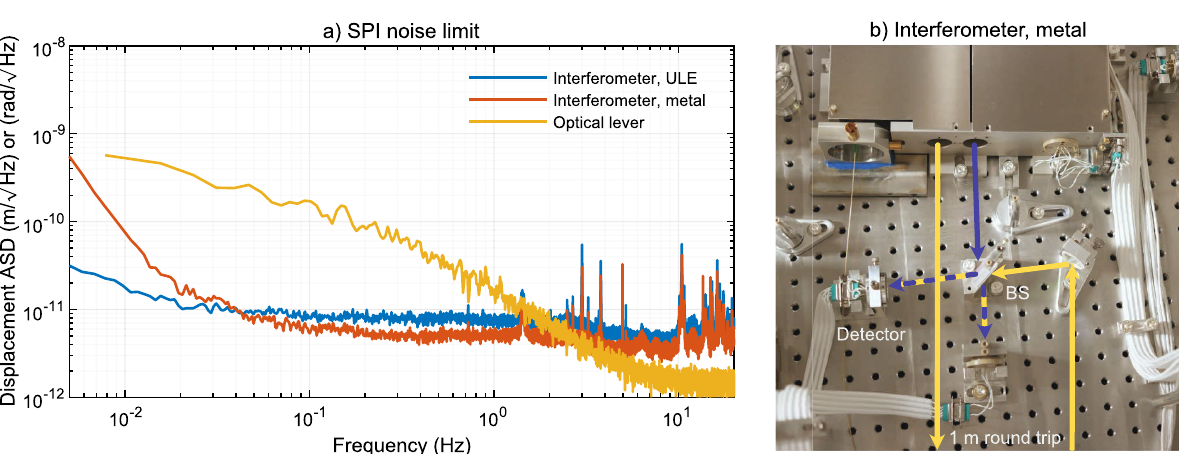
Figure 4. A simplified schematic of the angular sensing with the optical levers of the SPI. Each optical lever travels from one to the other AEI-SAS platforms. At the time of the experiment two AEI-SAS were installed. The feedback signals are processed in the CDS and applied to the AEI-SAS platforms for pitch and yaw control. An additional optical lever was used for out-of-loop measurements and is not shown in this figure. The photographs show parts of the optical lever hardware on the central and remote AEI-SAS.